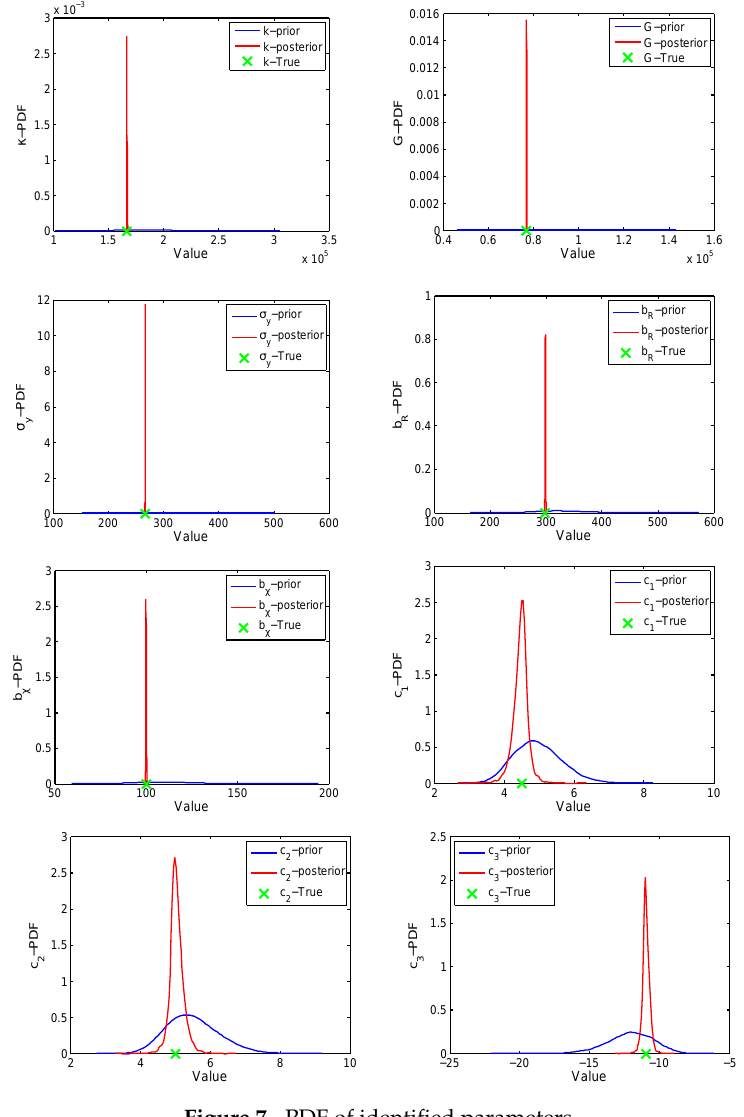
Figure 7. PDF of identified parameters.